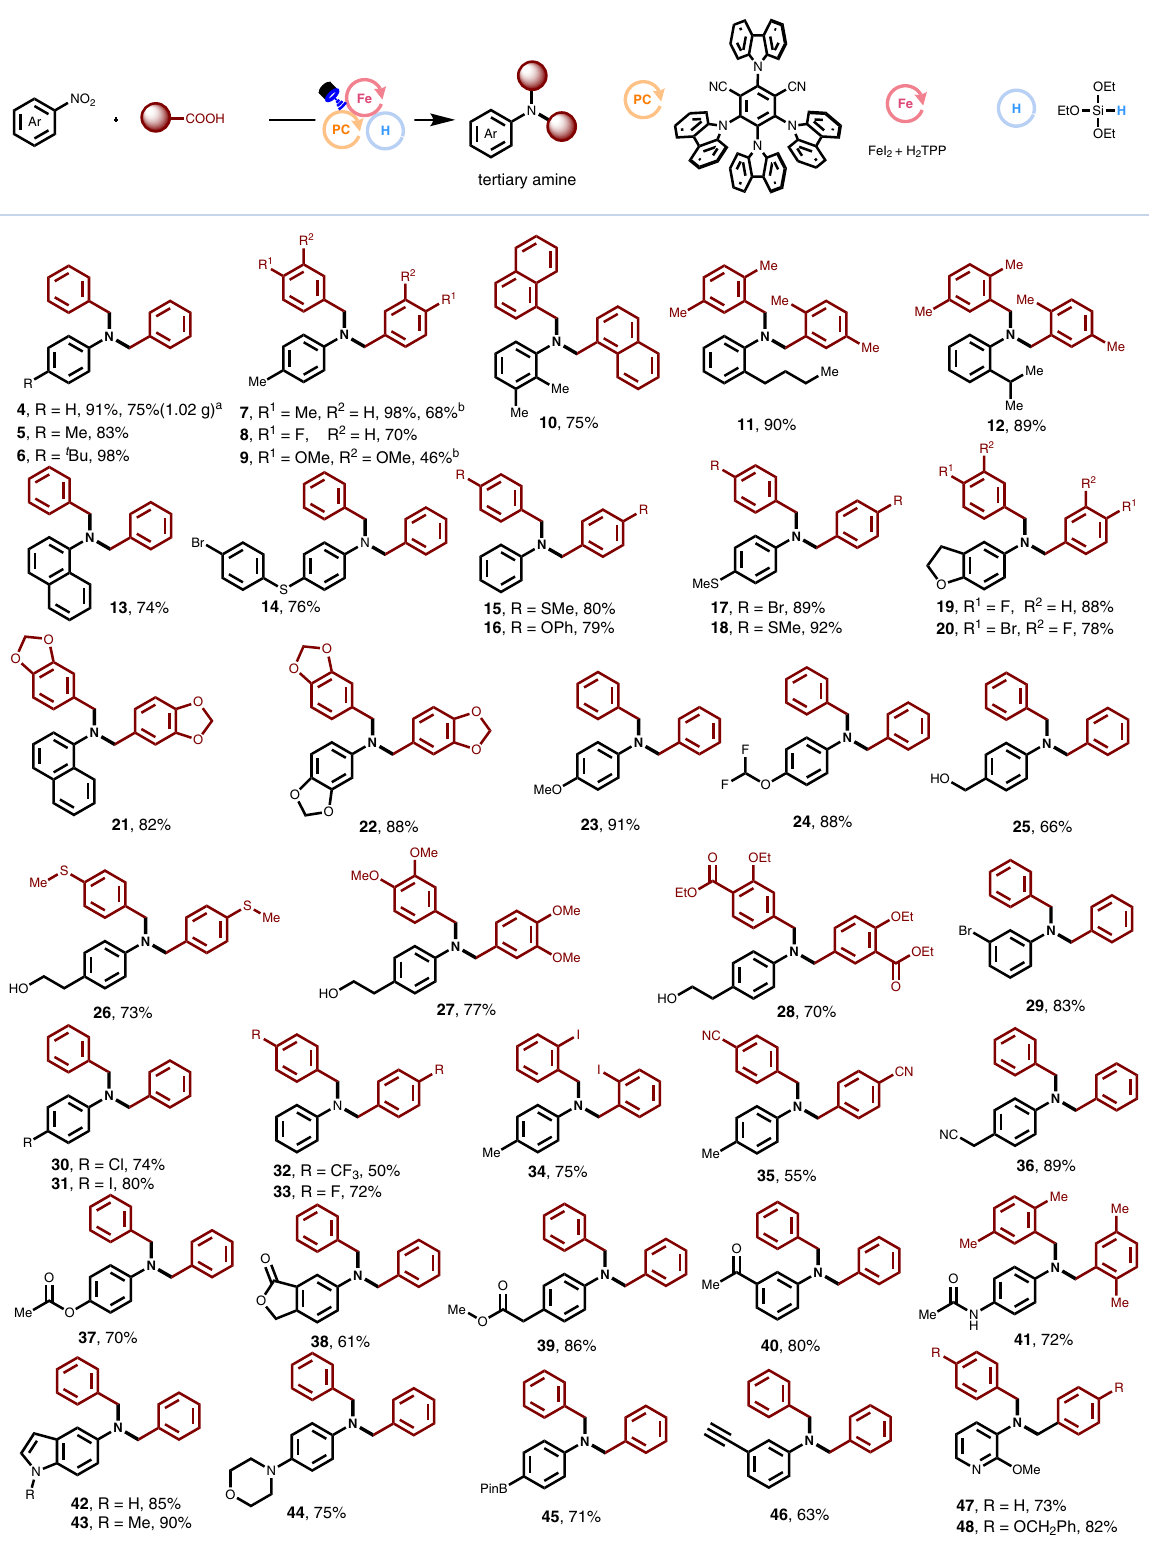
Fig. 2 Scope of the carboxylic acids and the nitro compounds. Reaction conditions: 4CzIPN (1 mol%), FeI 2 (10 mol%), L1 (10 mol%), nitrobenzene (0.2 mmol), carboxylic acid (0.6 mmol), 2,6-lutidine (3.0 equiv.), (EtO) 3 SiH (2.0 equiv.), MeCN (2 mL), blue LEDs, 65 °C, 24 h. a Gram-scale test with 0.2 mol% photocatalyst. Standard conditions for gram-scale experiment: PC 3 (0.2 mol%), L1 (10 mol%), FeI 2 (10 mol%), phenylacetic acid 1 (15 mmol), nitrobenzene 2 (5 mmol), 2,6-lutidine (15 mmol), (EtO) 3 SiH (10 mmol), MeCN (25 mL), blue LEDs, 65 °C, 72 h. b Reaction time = 45 h, 25 °C.